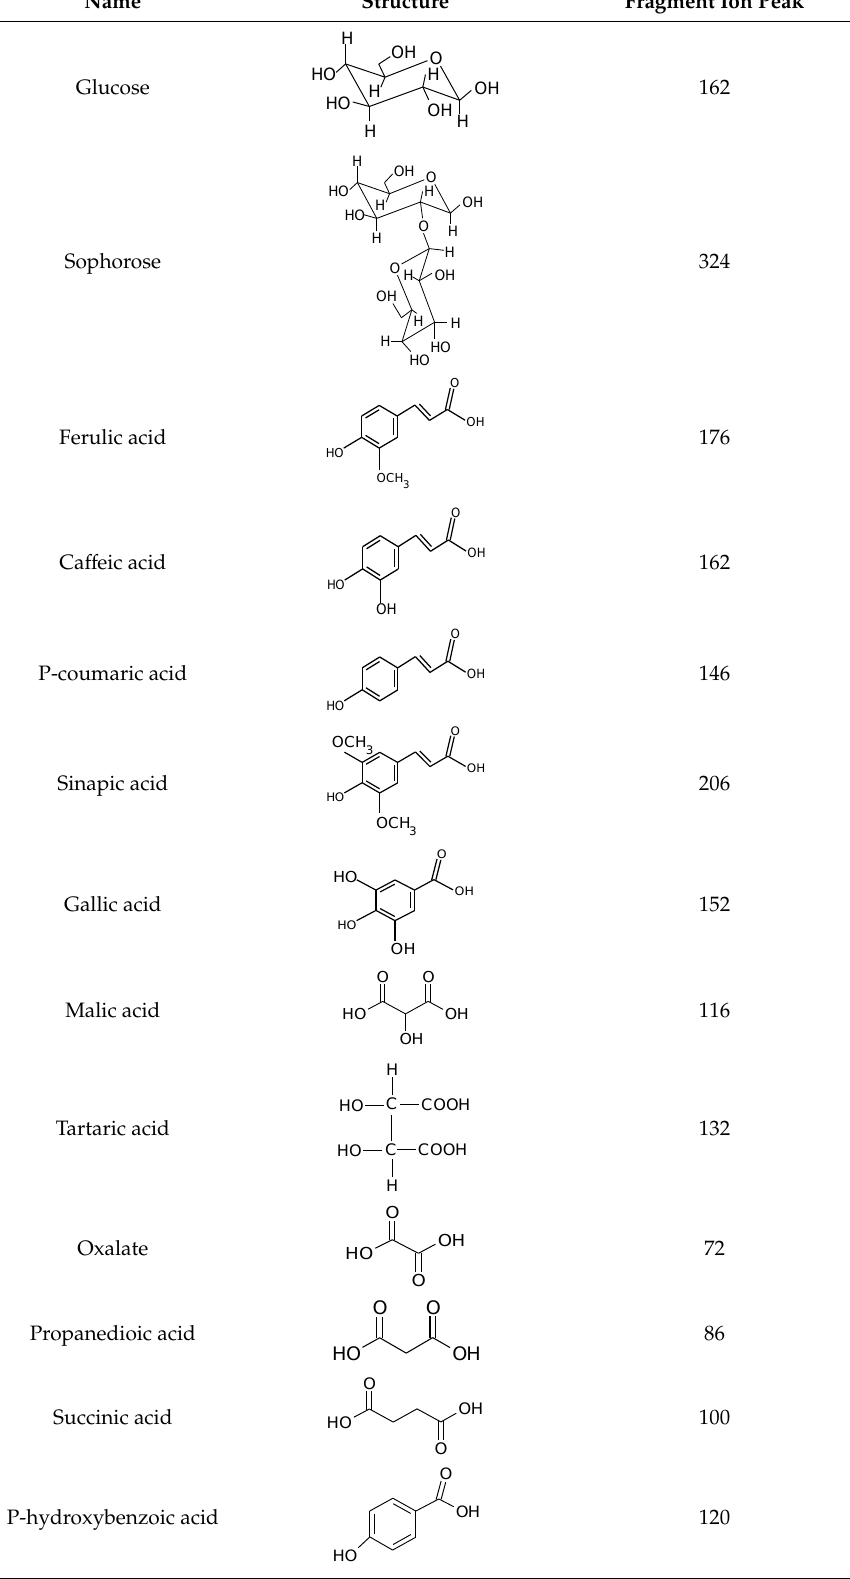
Table 1. Structural information of glycosides and acyl substrates in common purple sweet potato anthocyanins (PSPAs).